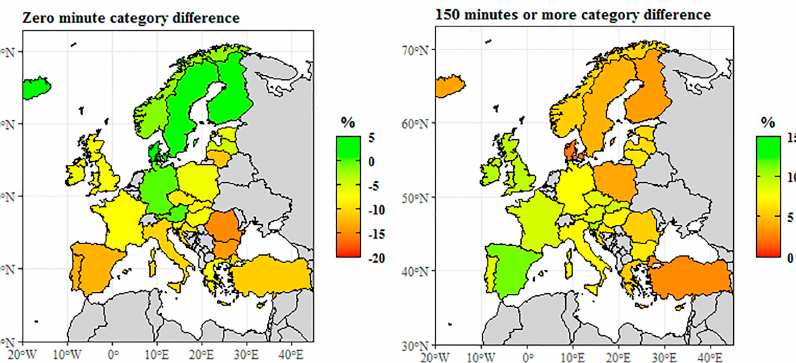
Figure 2. Time spent on health-enhancing (not work-related) aerobic physical activity by sex difference (male – female, in %, 2014). Source: [136].